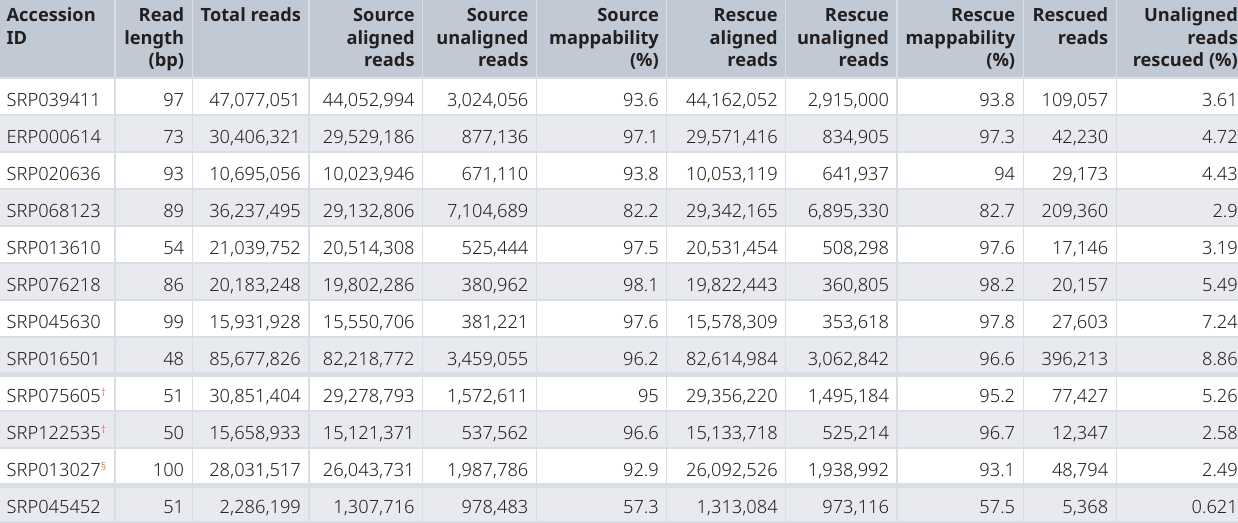
Table 6. Alignment statistics for all RNA-seq datasets in source alignment with STAR and after recovery of reads with Scavenger. The datasets are divided into three sections: 1. Datasets from selected non-reference mouse strain, 2. Normal (bulk) RNA-seq dataset from either human († ) or mouse ( § ), and 3. Single-cell RNA-seq dataset from